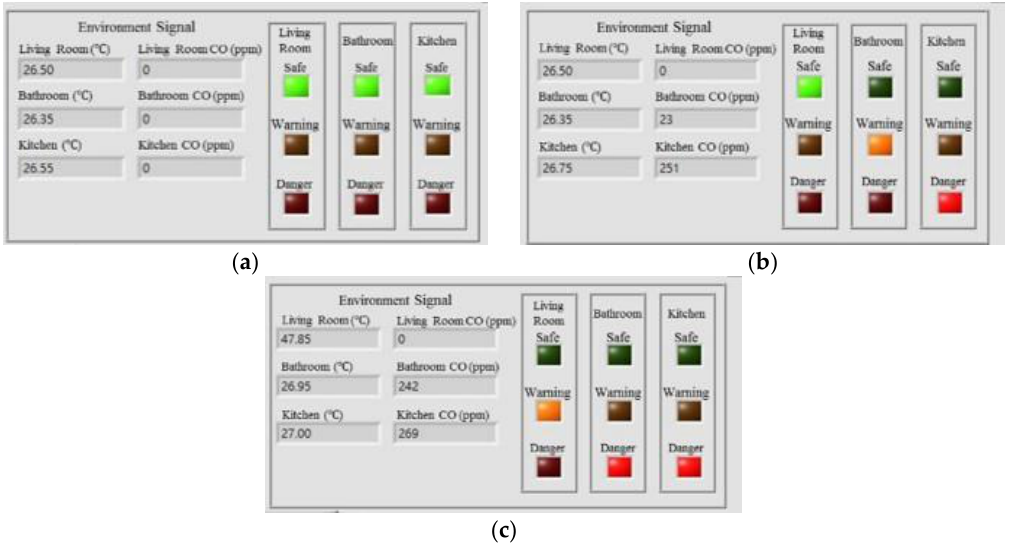
Figure 21. Experimental results of the home safety and fire detection. ( a ) The conditions of the living room, kitchen, and bathroom are all safe; ( b ) The living room is safe, kitchen is warning, and bathroom is danger; ( c ) The living room is warning, and kitchen and bathroom are both danger.